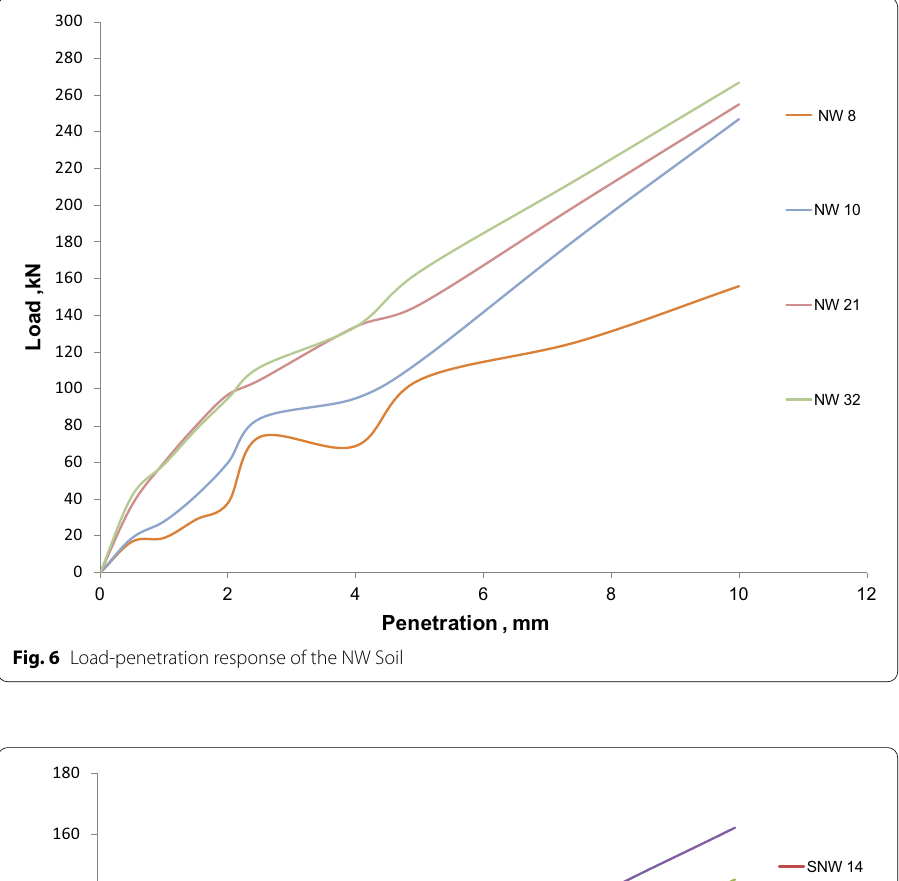
Fig. 6 Load-penetration response of the NW Soil